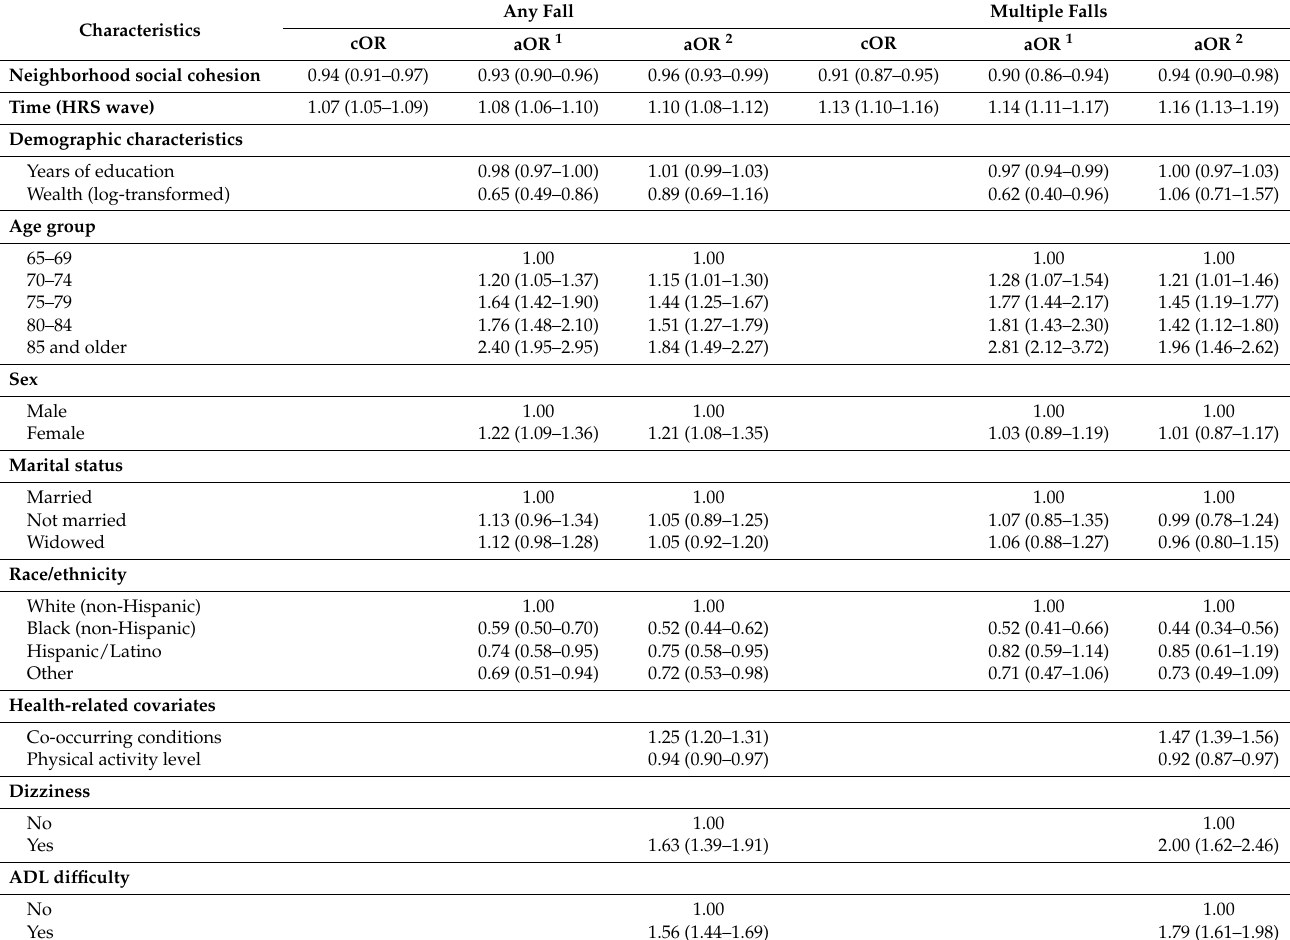
Table 2. Neighborhood social cohesion and odds of falls using mixed-effect logistic regression models (robust variance estimation), n = 9259.